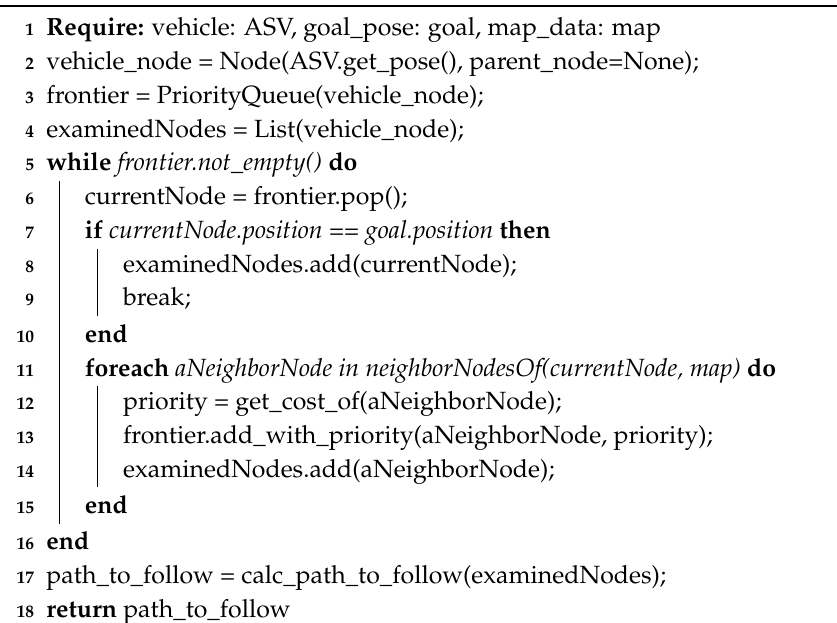
Algorithm 2: A* planning algorithm